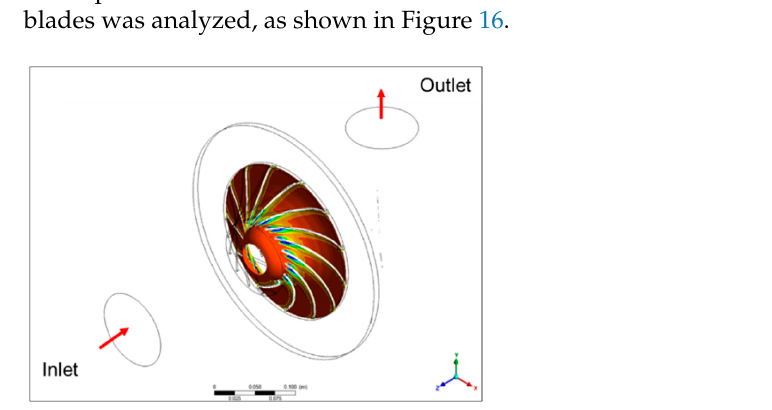
Figure 16. Schematic diagram of the inter-blade flow field of a refrigerant compressor .